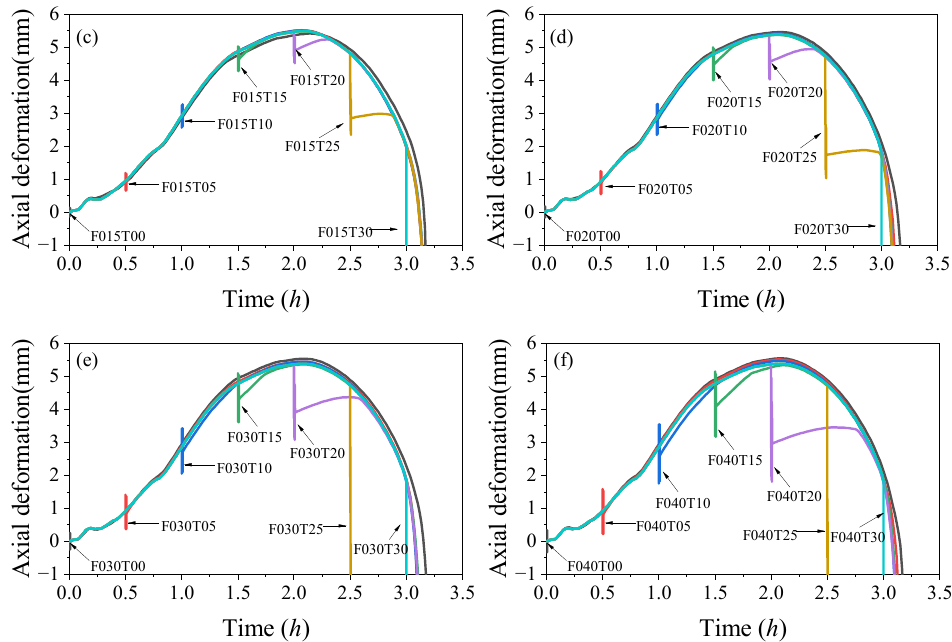
Figure 10. Axial deformation-time curve of different working conditions. ( a ) 𝐴 = 0.05; ( b ) 𝐴 = 0.10;